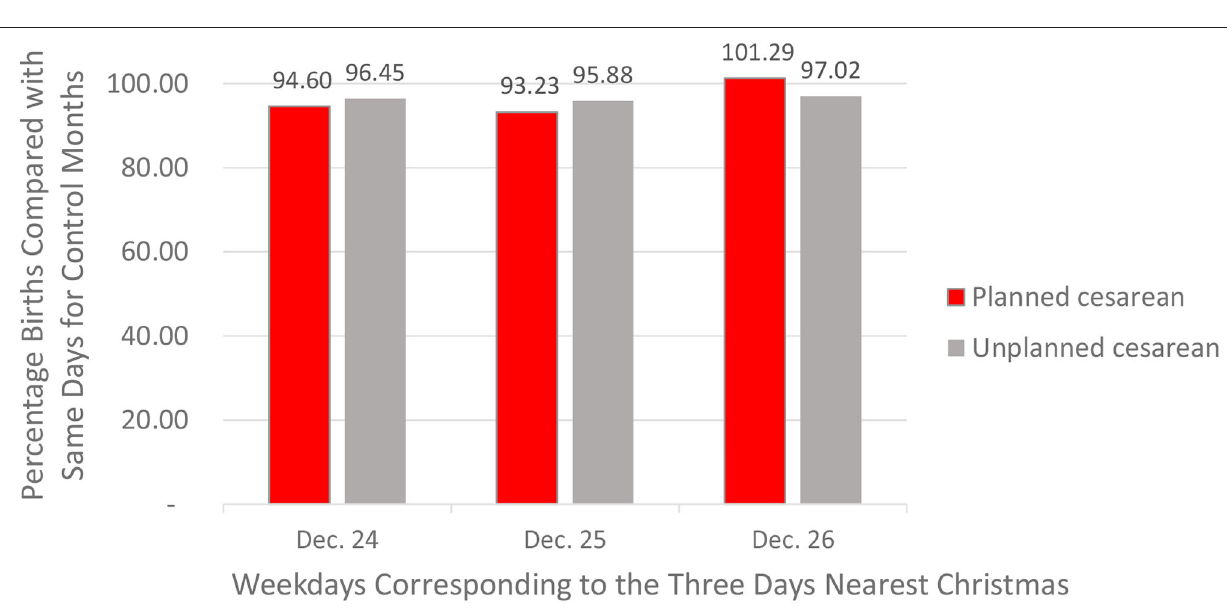
which birth rates were higher than expected. In retrospect,